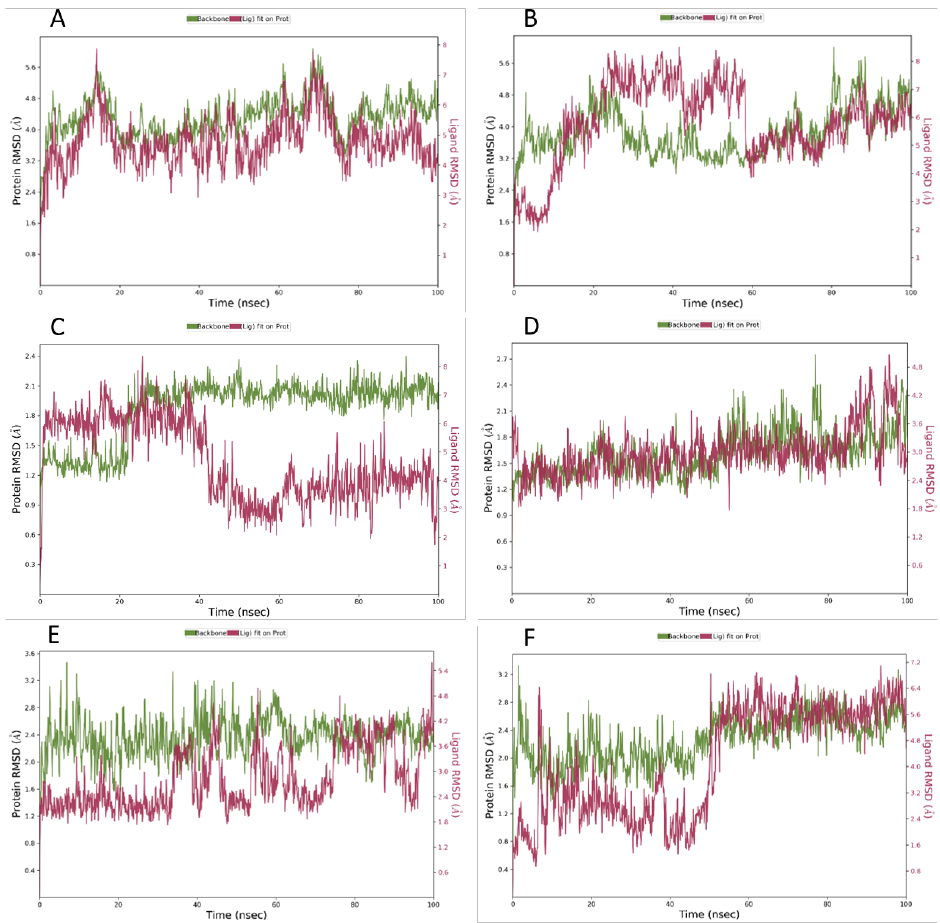
Figure 2. Root mean square deviation (RMSD) plot for ligand–protein interaction. ( A , B ): Nintedanib and Baricitinib on ACE2 Protein, PDBID: 6M1D; ( C , D ): Nintedanib and Darunavir on M pro , PDBID: 5R82; ( E , F ): Nintedanib and Quercetin on Spike Protein. PDBID: 1ZV8.